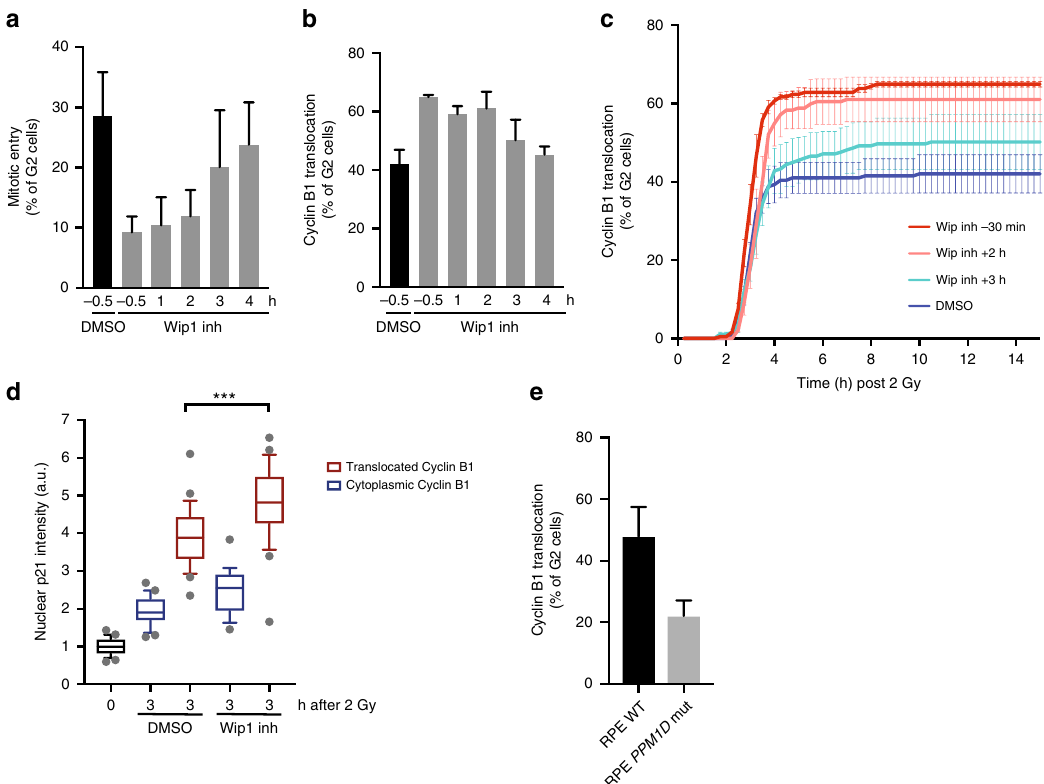
Fig. 3 Timely negative feedback is crucial to prevent irreversible cell cycle exit in G2 phase. a Mitotic entry scored in RPE CCNB1 YFP cells within 15 h following IR (2 Gy). Wip1 inh or DMSO were added at indicated timepoints before or after IR. Average of three independent experiments + sem. b Percentage of cells that translocate Cyclin B1 following IR treated as in a . Average of three independent experiments + sem. c Cumulative onset of nuclear translocation of Cyclin in cells treated in b . Average of three independent experiments + sem. d Nuclear p21 intensity in G2 cells 3 h after 2 Gy in presence or absence of Wip1 inhibition. Cells that translocated Cyclin B1 to the nucleus were separated from cells with cytoplasmic nuclear B1 localization. n > 18 cells from representative experiment. Box plot whiskers indicate 10 – 90% boundary. *** p < 0.005 two-sided t -test. e Percentage of G2 cells that translocate Cyclin B1 to the nucleus and exit the cell cycle following IR (2 Gy) in RPE CCNB1 YFP cells with wild-type or truncated Wip1. Average of three independent experiments +